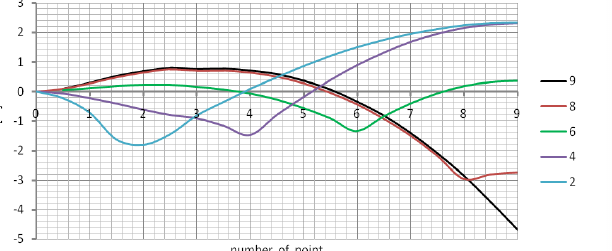
Figure 8: Functions of the influence of bending moments for the analysed shell’s points.